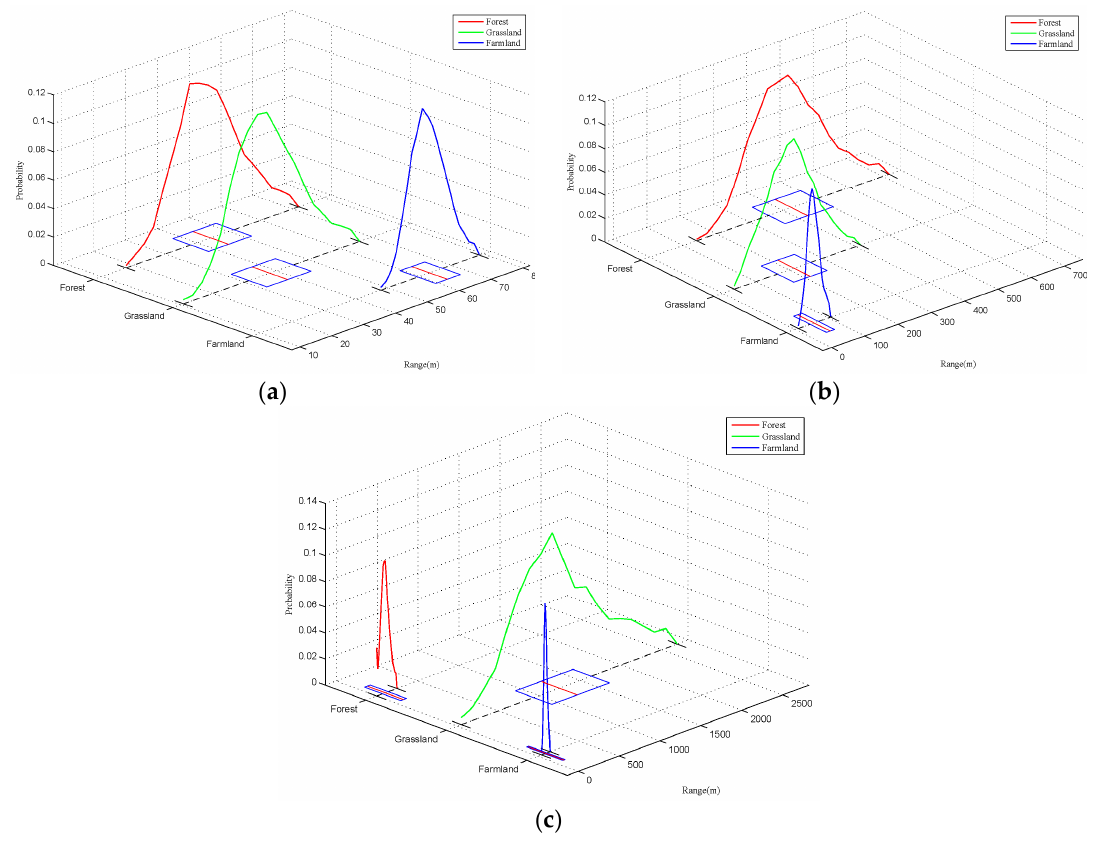
Figure 11. Probability distributions for the ranges for: Ansai County ( a ); Taihe County ( b ); and Changdu County ( c ).